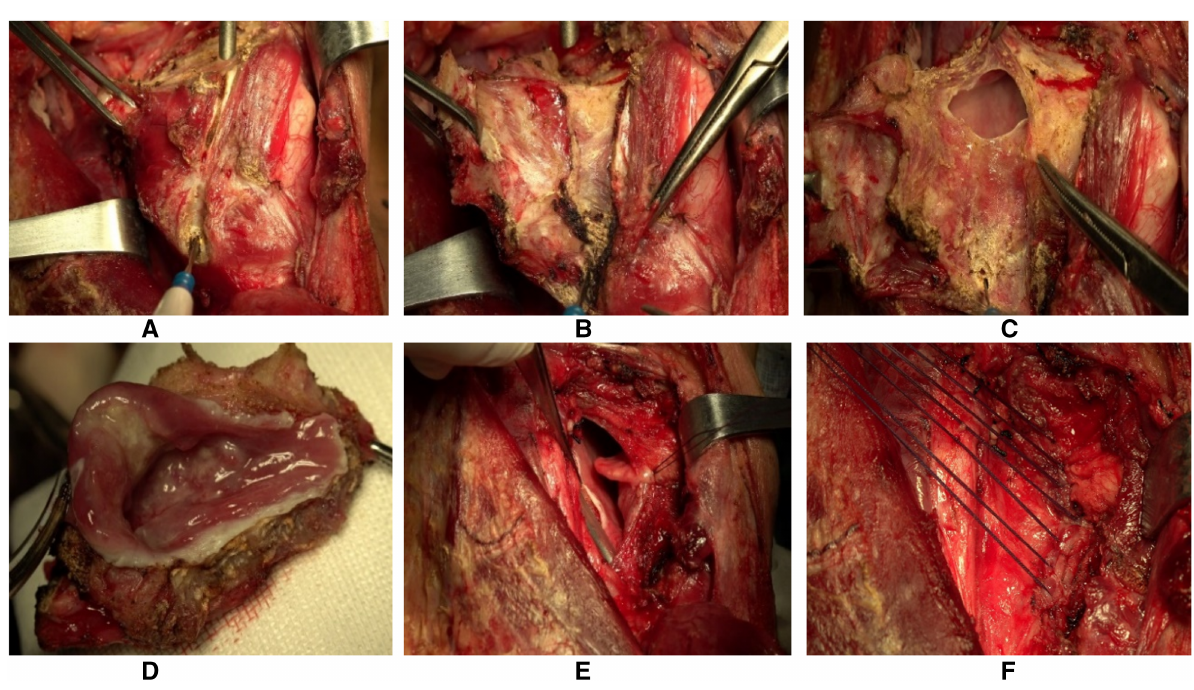
FIGURE 6 Pictures of surgical procedures. ( A ) Exposure of lateral edge of thyroid cartilage plate. ( B ) After the moderate outwards traction and lysis of the surrounding tissue, the parglottic space was exposed. ( C ) Enter the pharyngeal cavity from the paraglottic space and remove the tumour under direct vision. ( D ) Remove the tumour along the safe boundary of the tumour. ( E ) the mucosa of the posterior wall of the hypopharynx is sutured up and down to widen the pharyngeal cavity. ( F ) Suture the pharyngeal mucosa and close the pharyngeal